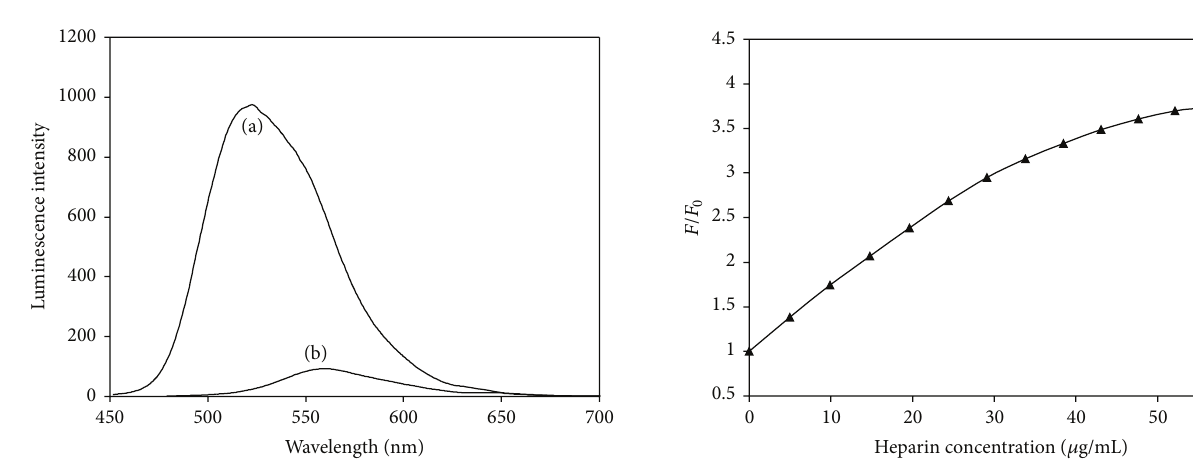
Figure 2: Luminescence spectra of (a) [Os(phen) 2 CO(PPh 3 )](PF 6 ) 2 and (b) [Os(phen) 2 CO(py)](PF 6 ) 2 in ethanol solution (2.4 mg/ 100mL).